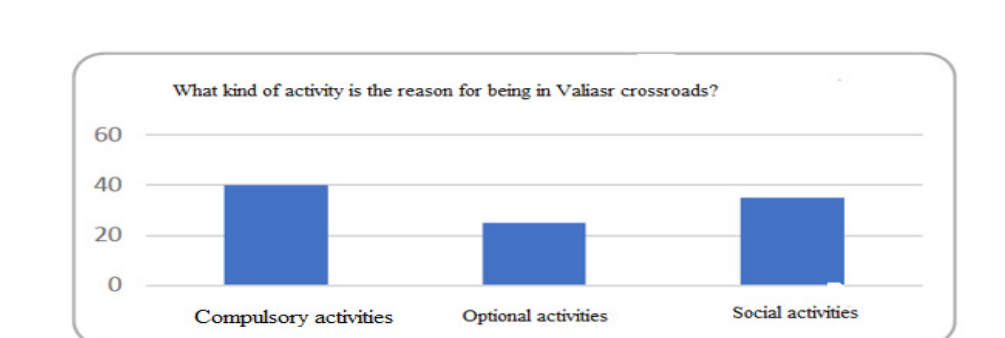
Fig . 6: Separation of sample community activities Fig. 6: Separation of sample community activities